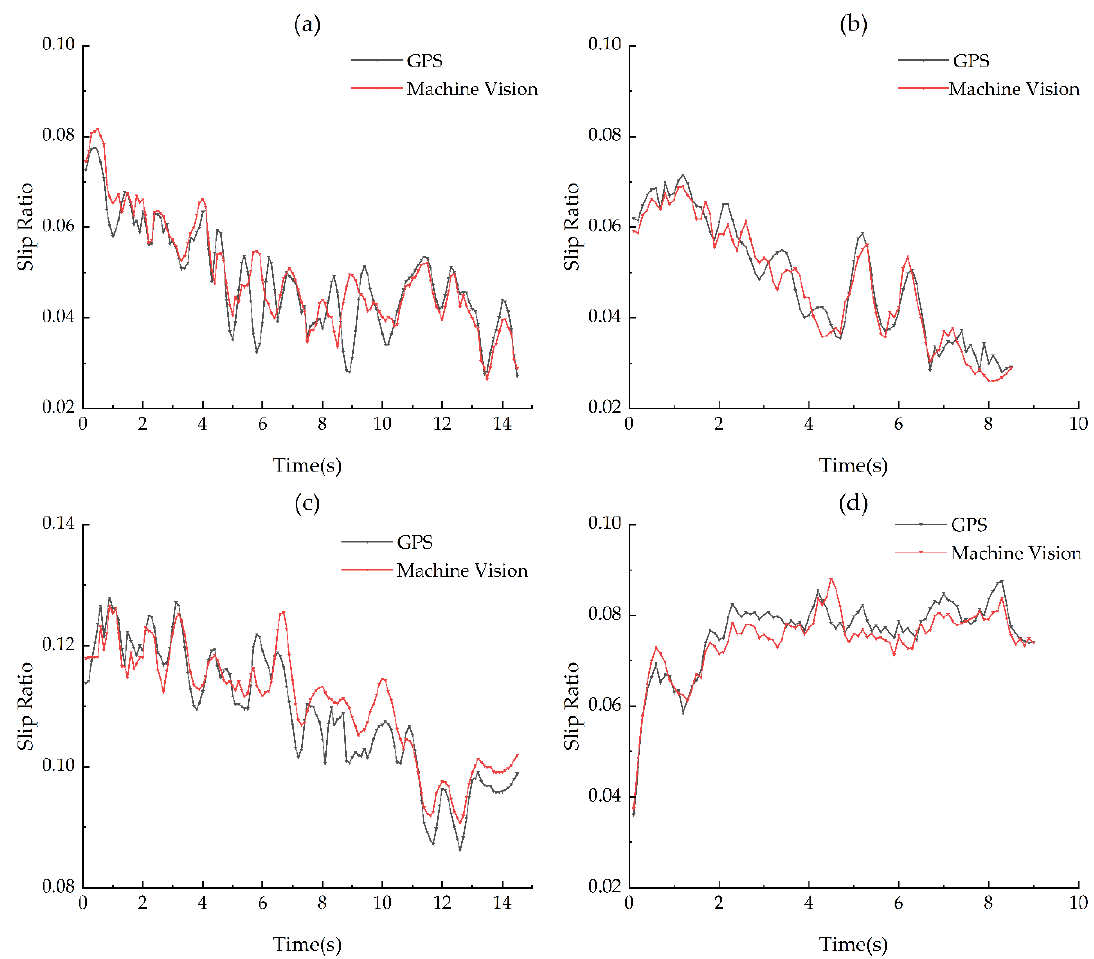
Figure 9. The results of the slip ratio for tractor driving wheels on the asphalt ground, where ( a ) is under the working condition of low velocity and low tire inflation pressure, ( b ) is under the working condition of high velocity and low tire inflation pressure, ( c ) is under the working condition of low velocity and high tire inflation pressure, ( d ) is under the working condition of high velocity and high tire inflation pressure. Table 5. In various working conditions of the asphalt ground, the absolute errors of the slip ratio for the tractor driving wheels were obtained by comparing the machine vision method with the GPS